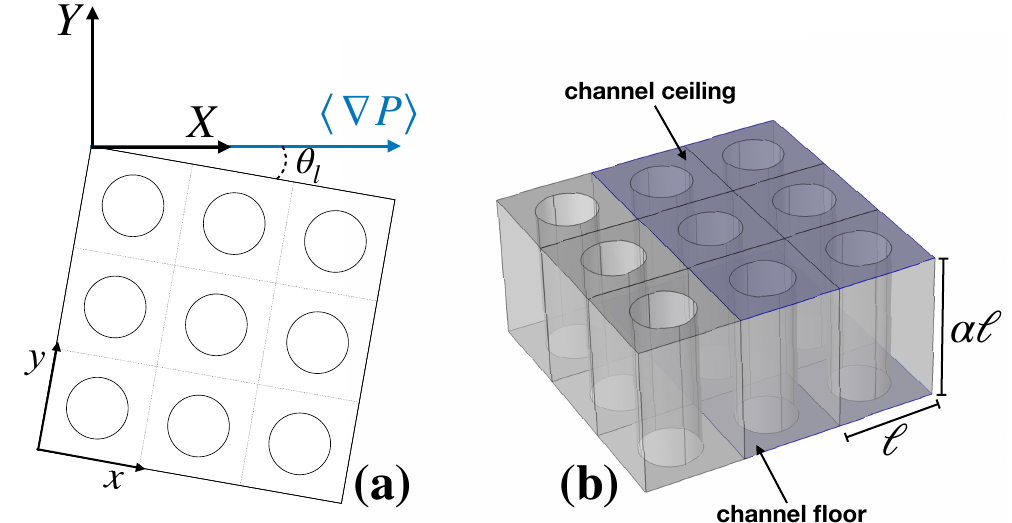
Figure 3. Geometry of the 3D lattice and system parameters. ( a ): Top view of the obstacle lattice and definition of the global and local coordinate systems; ( b ): Three dimensional structure of the lattice showing the cell aspect ratio α and the top and bottom walls of the